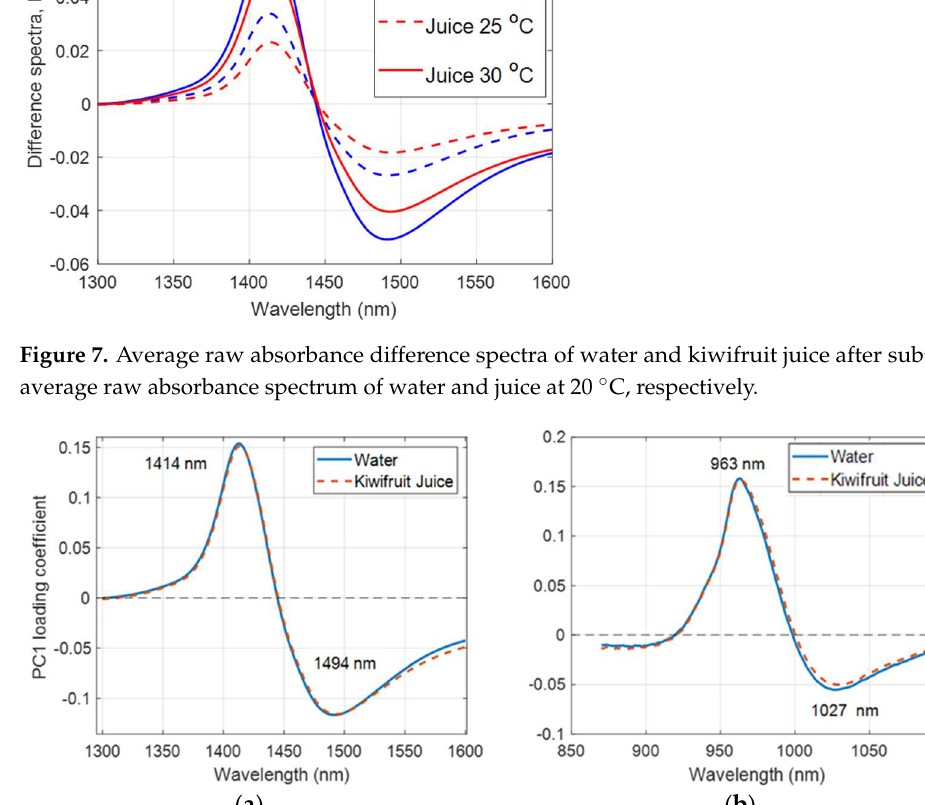
Figure 8. PC1 loading of water and juice difference matrix in the ( a ) 1300–1600 nm region with a 1 mm cuvette; and ( b ) 870–1100 nm region with a 10 mm cuvette. Labels indicate the peak and trough wavelengths.